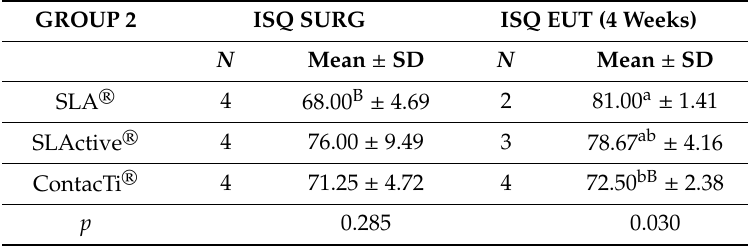
Table 2. Relative means of the ISQ value in the measurements performed in group 2 (euthanasia at 4 weeks), both on the day of surgery (ISQ SURG) and at the time of euthanasia (ISQ EUT), for each of the three groups. The lowercase letters show in standard form (columns) the di ff erences in pairs between the means by the Tukey method after detecting statistical significance in the